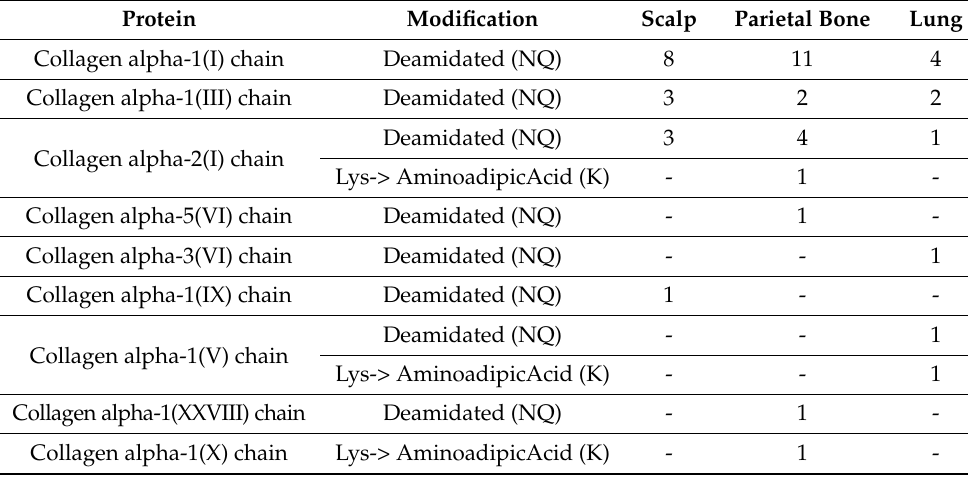
Table 2. Ancient modifications identified in proteins extracted from Nebiri’s remains. The name of the protein, type of modification, and number of modified amino acids in each sample for each protein are reported. Protein Modification Scalp Parietal